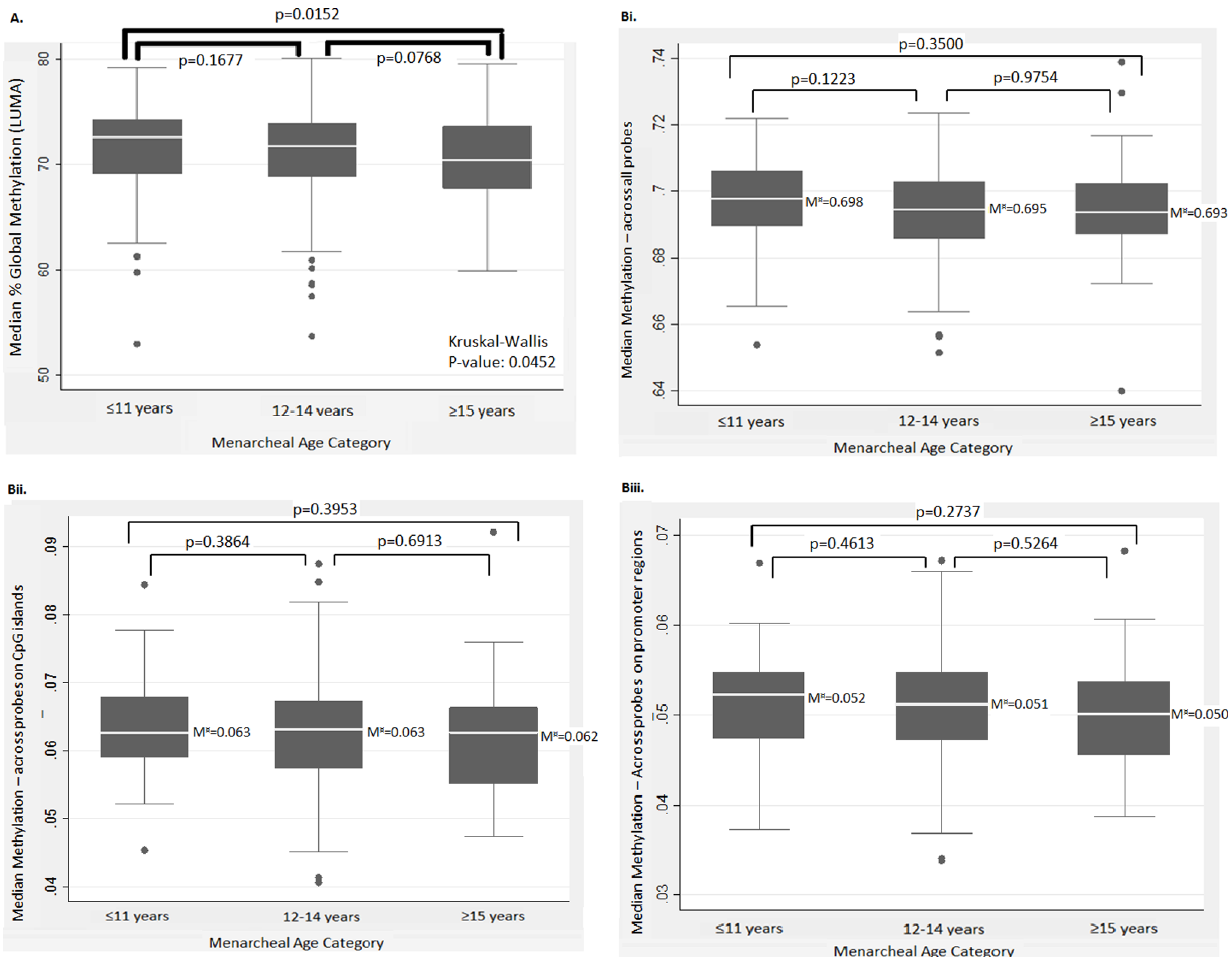
Figure 1. Boxplots of median genome-wide methylation between the three menarcheal age categories. A: Median % global methylation as measured with LUMA in Stage 1. Bi. Genome-wide methylation across all probes (averaged per individual). Bii. Genome-wide methylation across probes on CpG islands (averaged per individual). Biii. Genome-wide methylation across probes on promoter regions (averaged per individual). M ¤ =Median methylation value. p=p value from Wilcoxon rank-sum test comparisons.